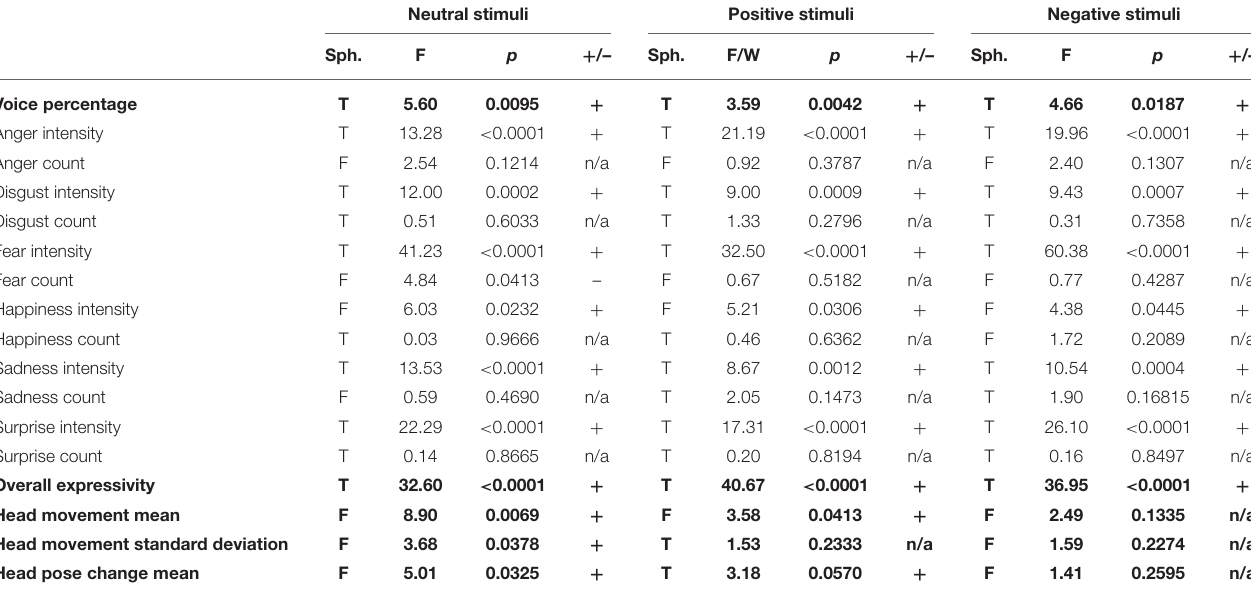
TABLE 1 | Repeated-measures ANOVA results for all visual and voice markers measured in response to positive, negative, and neutral visual stimuli from baseline to 4 weeks of ADT. Neutral stimuli Positive stimuli Negative